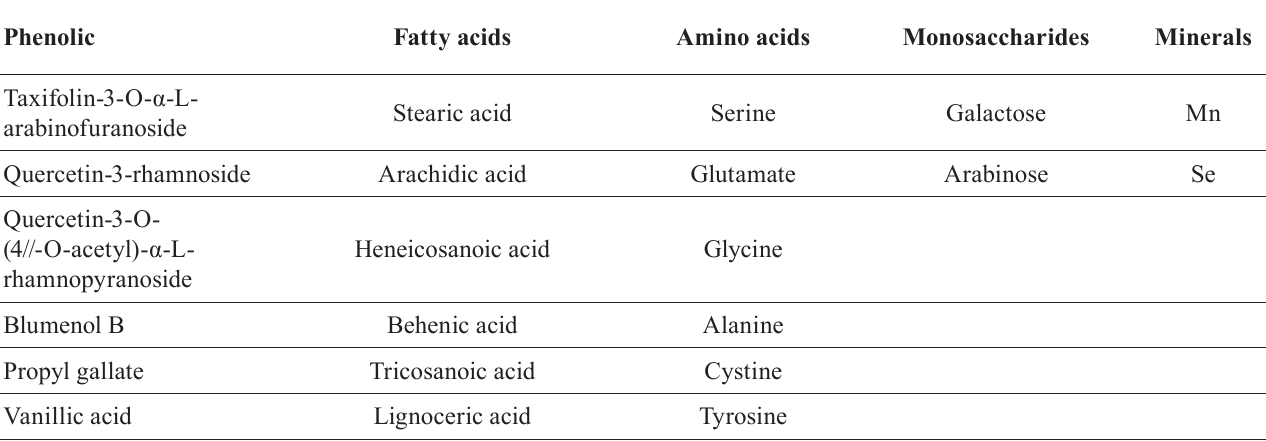
TABLE I - C hemical compositions and nutritional attributes of WEW